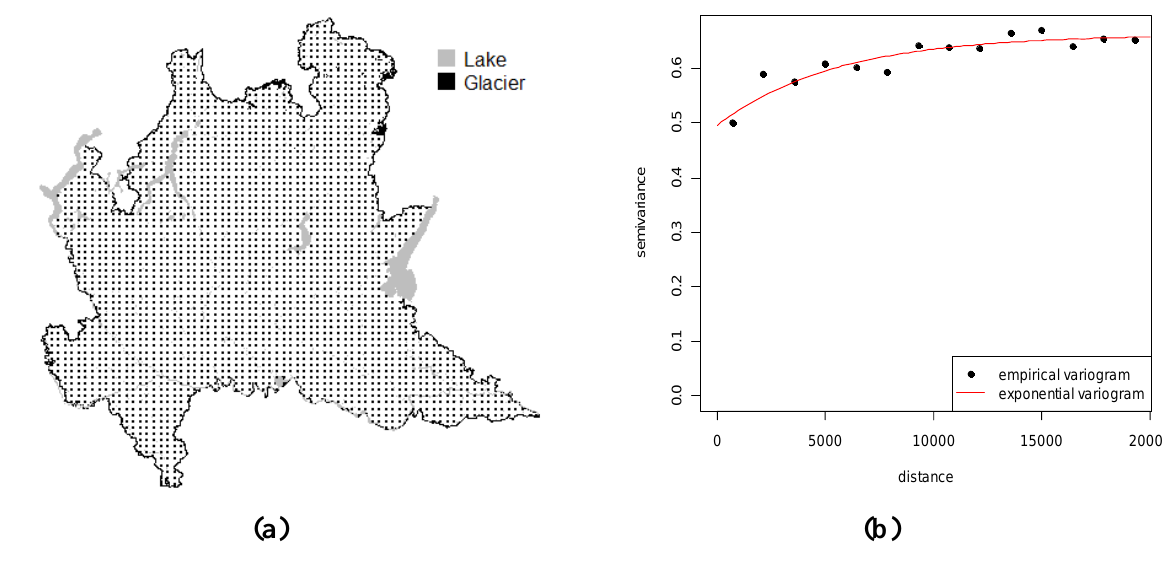
Table 4. Number of grid points by geological classes.